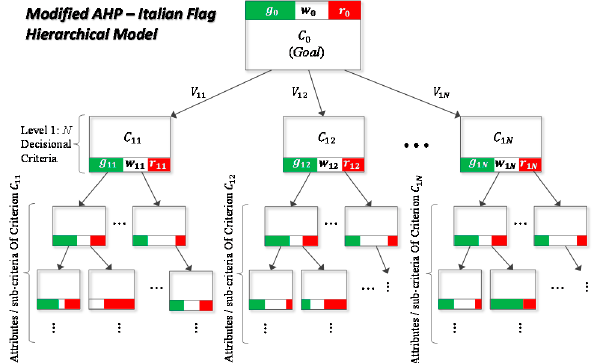
Figure 16. AHP–IF hierarchical model. General schema of the modified AHP hierarchical model integrated with IF representation.